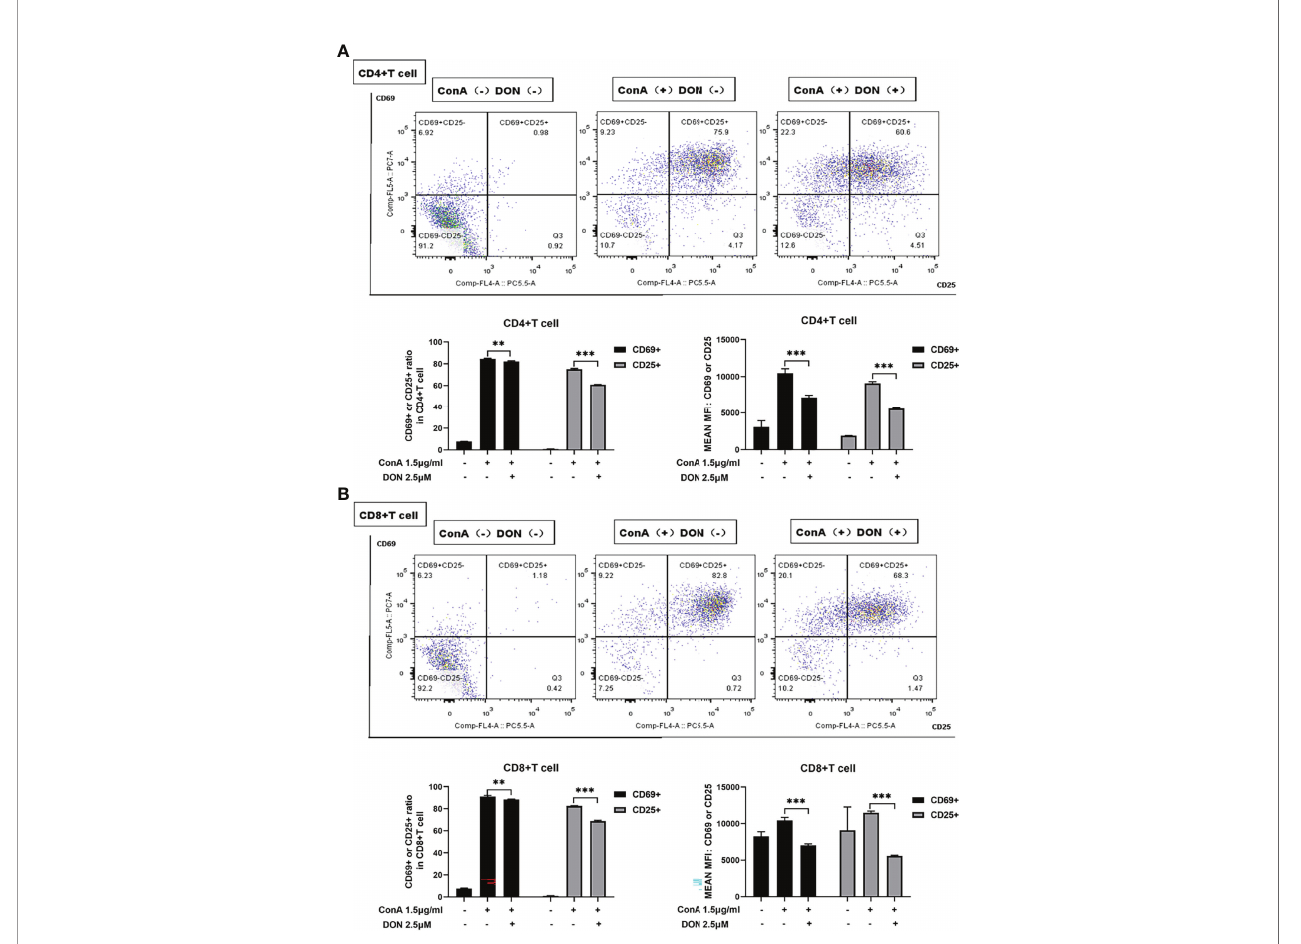
FIGURE 4 | DON treatment suppressed T cells activation in vitro . Freshly separated spleen cells were stimulated with 1.5mg/ml ConA with or without treating 2.5 m M DON, and cells were analyzed 24h after ConA stimulation. (A, B) The expressions of activation markers CD25 and CD69 in CD4(+) (A) and CD8(+) (B) T cells were examined by fl ow cytometry. Data were expressed as means ± SEM. ** P <0.01, and *** P